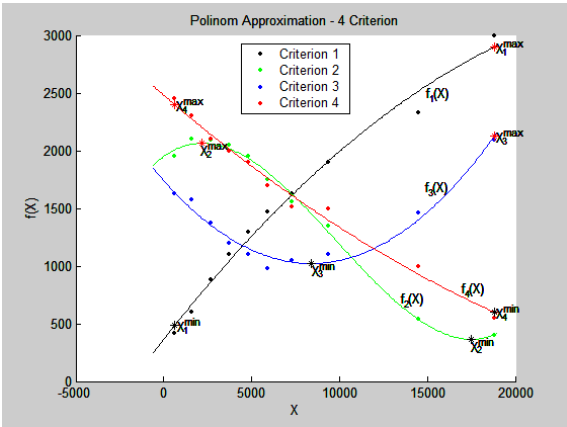
Figure 1. Polynomial approximation of four criteria.